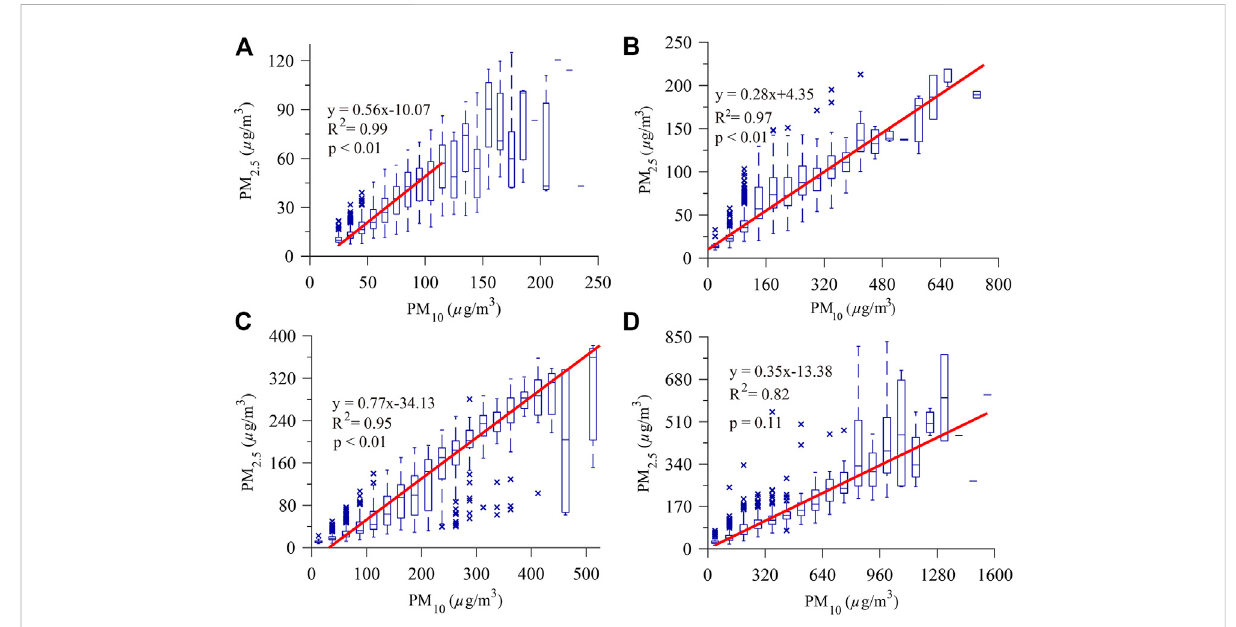
FIGURE 8 BoxplotsofdailyaveragePM 2.5 concentrationbasedonPM 10 concentrationin (A) regionI, (B) regionII, (C) region Ⅲ and (D) region Ⅳ ofXinjiang from 2013 to 2019. Red line shows the variation trend of median